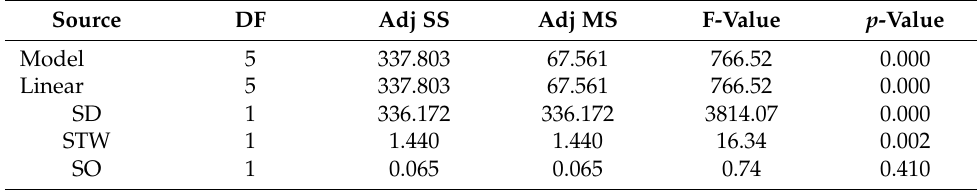
Table 4. Dispersion analysis of fractional factorial design for